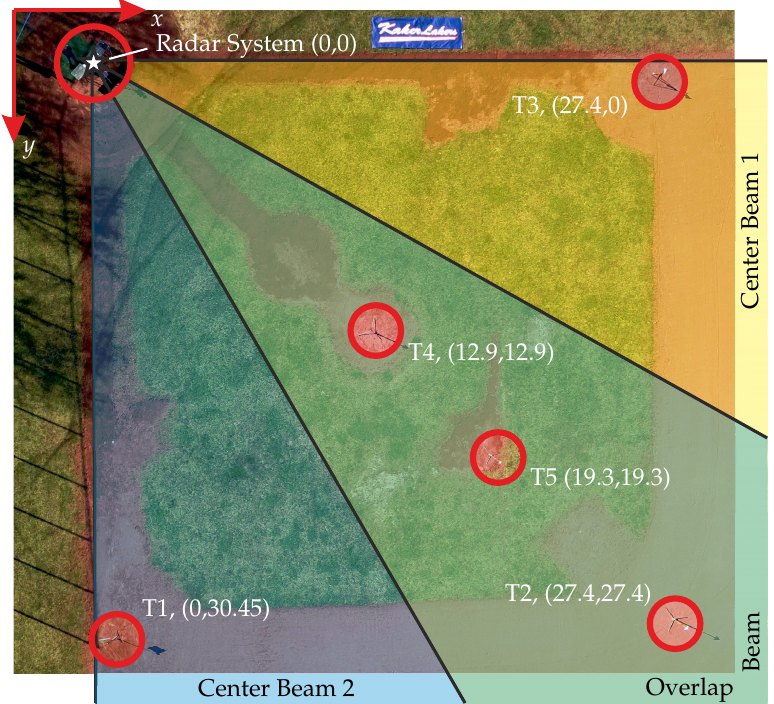
Figure 14. Drone footage of the measurement scenario with overlaid antenna beam areas and indicated target locations. Coordinates (x,y) of the targets T1-T5 are given in meter.